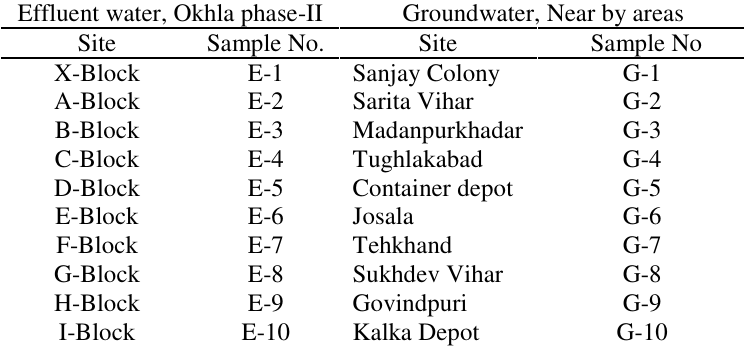
Table 1. Sample collection